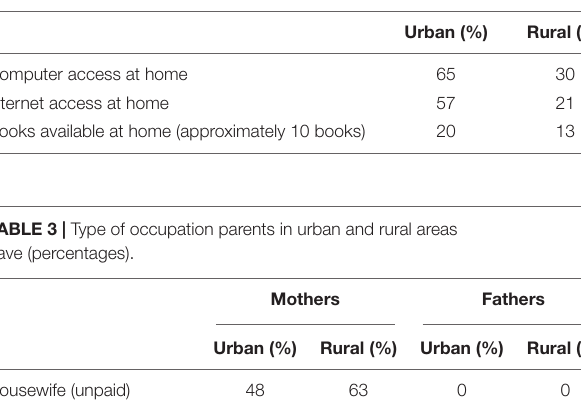
TABLE 2 | Available sources of learning support for students in urban and rural areas (percentages).